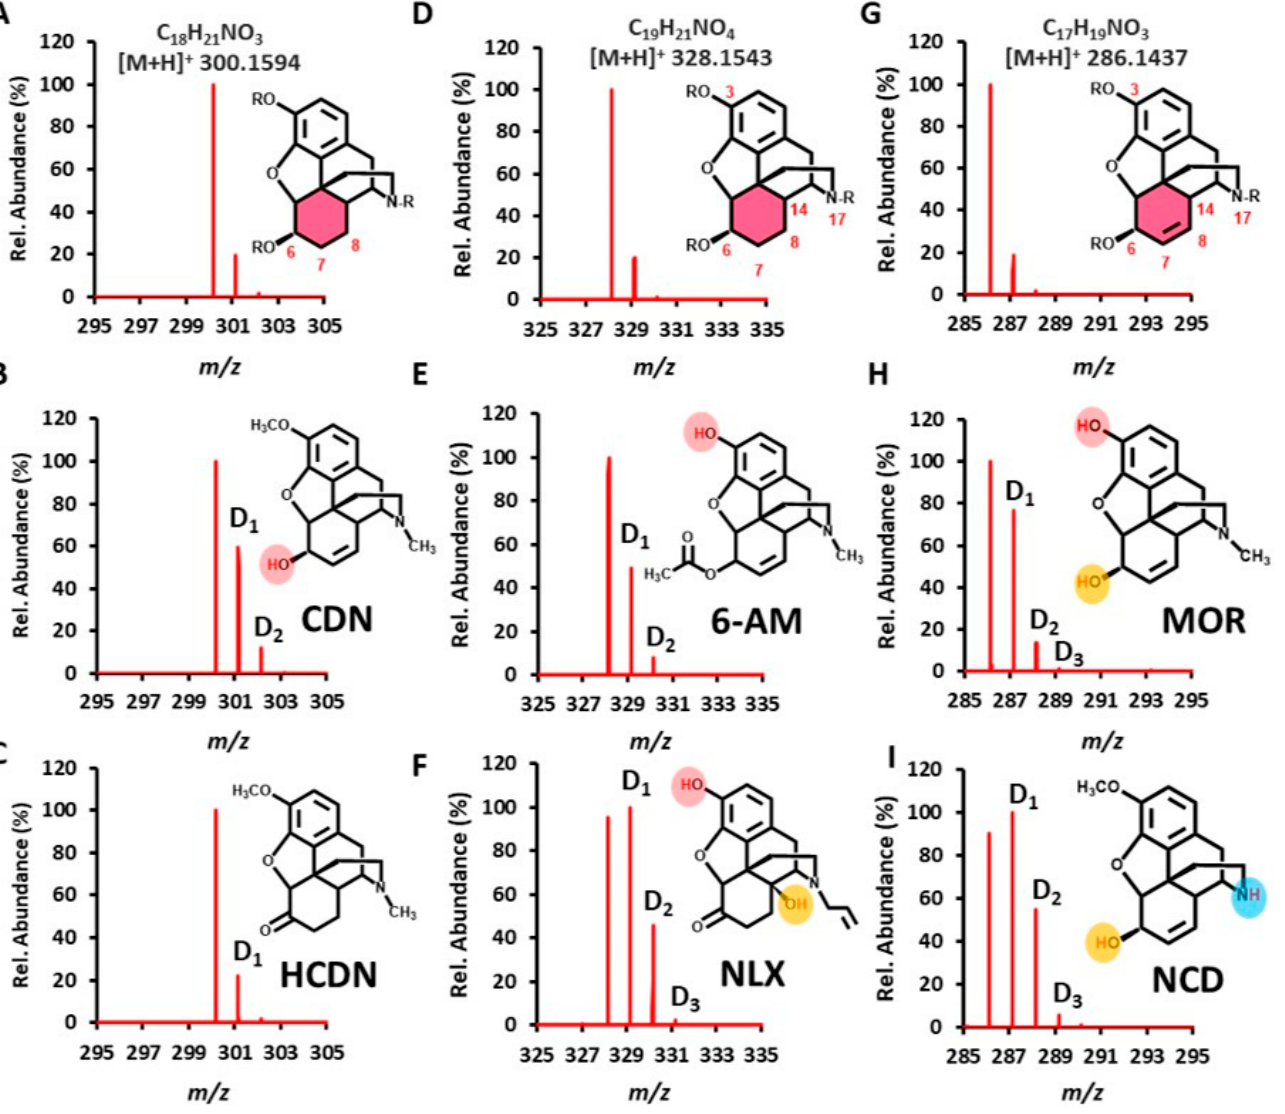
Figure 2. HDX pattern for distinguishing between three pairs of opioid drug ions. ( A , D , G ) High-resolution mass spectra and parent structures for three pairs of isobaric ions in mixed solutions: ( A ) C 18 HNO 3 , ( D ) C 19 H 21 NO 4 , and ( G ) C 17 H 19 NO 3 . Post-HDX mass spectra for ( B ) codeine (CDN), ( C ) hydrocodone (HCDN), ( E ) 6-acetyl morphine (6-AM), ( F ) naloxone (NLX), ( H ) morphine (MOR), and ( I ) norcodeine (NCD). Only deuterium peaks are annotated in mass spectra according to the mass shift of one deuteration, which is around 1.0063 ± 0.0002. Please note that the resolution of the mass spectrometer being used is unable to distinguish between the shift from 2 H and those from 13 C and 15